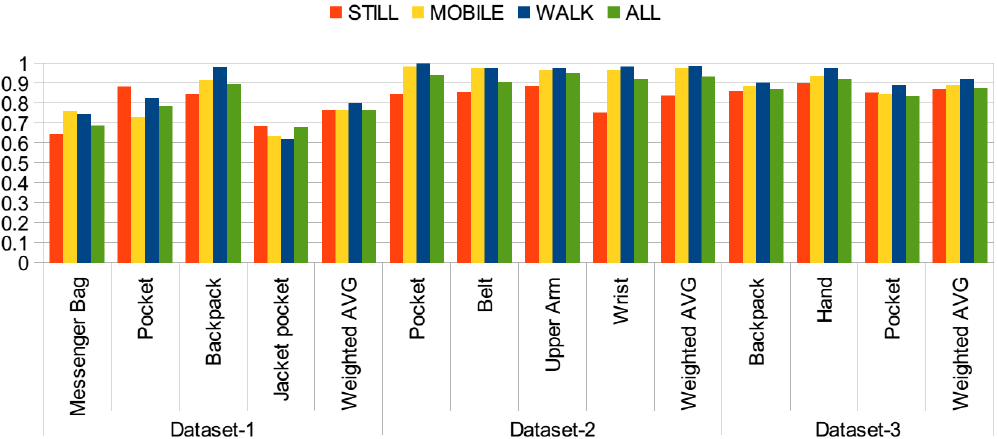
Figure 8. Accuracy when the activity information is available, individual datasets.